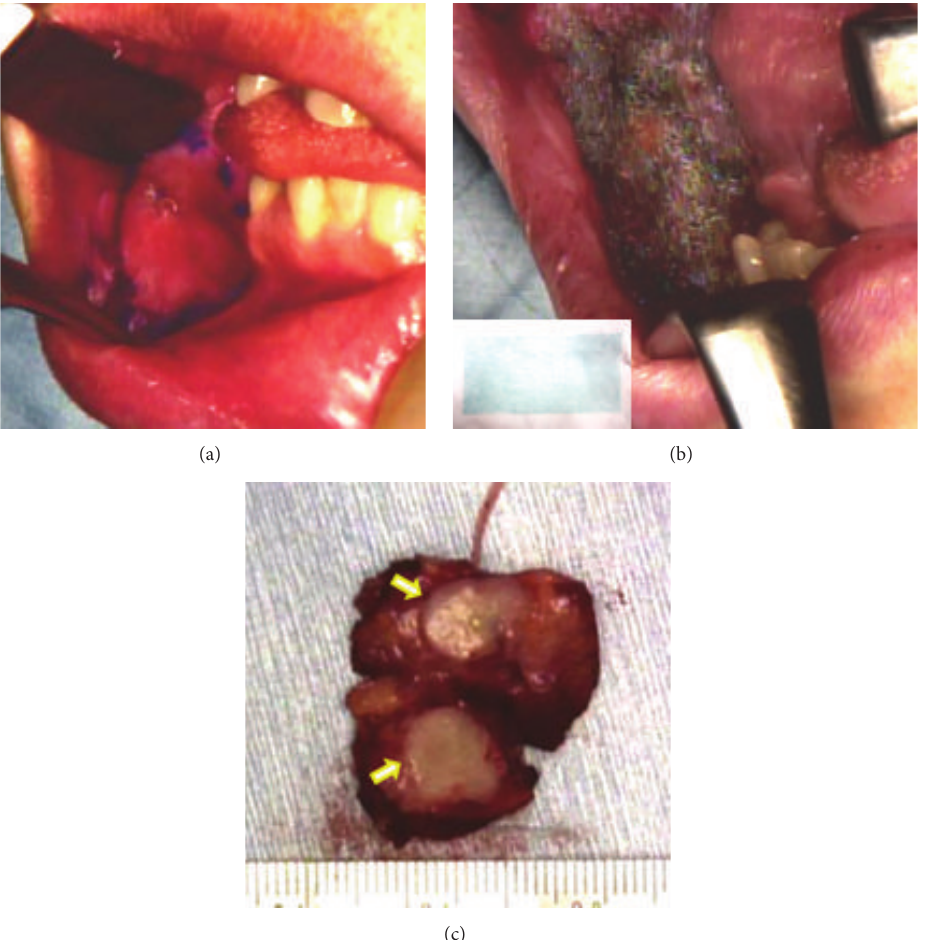
Figure 3: Operative findings. (a) The incision line (purple circle on the right buccal mucosa) was designed with a safety margin of about 1cm around the tumor. (b) The wound was covered with a graft using a polyglycolide acid sheet (PGA sheet, NEOVEIL; Gunze Ltd., Kyoto, Japan) and fibrin glue spray. The inserted figure at the lower left is from before use of the PGA sheet. (c) Cut surface of the resected tumor. Its section revealed a solid yellowish white cut surface with a smooth margin, without adhesion of the surrounding